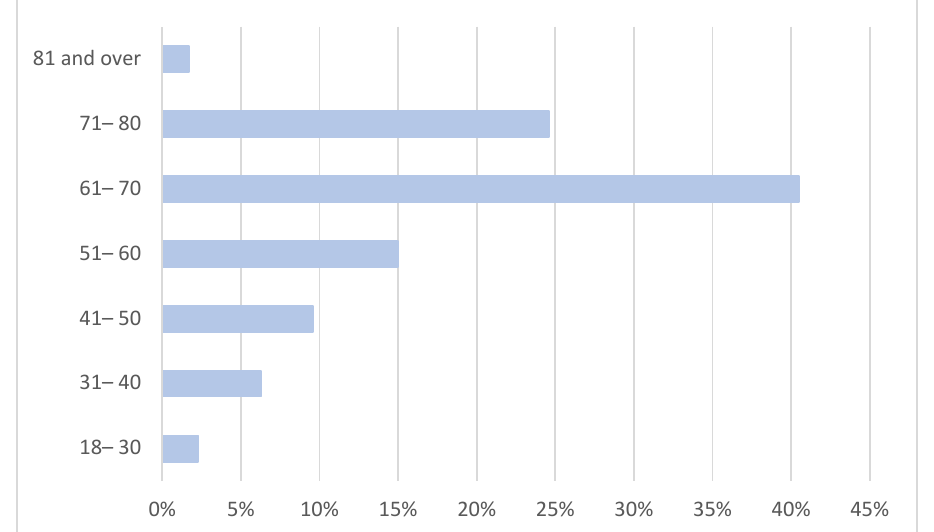
Figure 1. The respondents’ age ( n = 521) (source, own research). Table 1. Characteristics of the survey population by sex and social status ( n = 521).